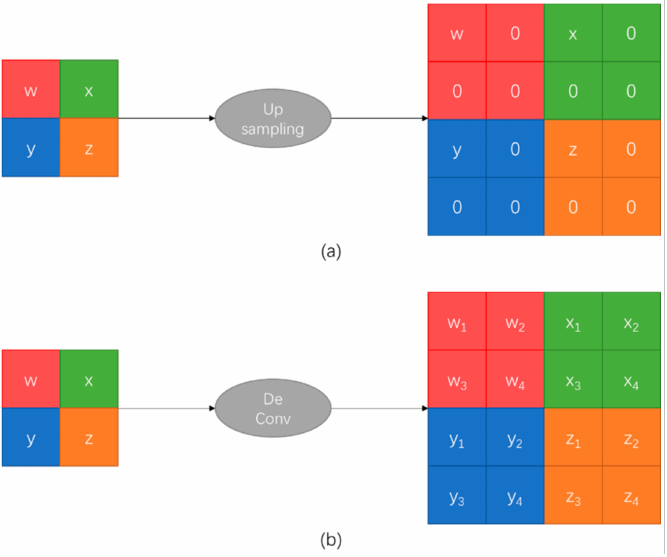
Figure 5. Upsampling and deconvolution: ( a ) upsampling; ( b ) deconvolution.